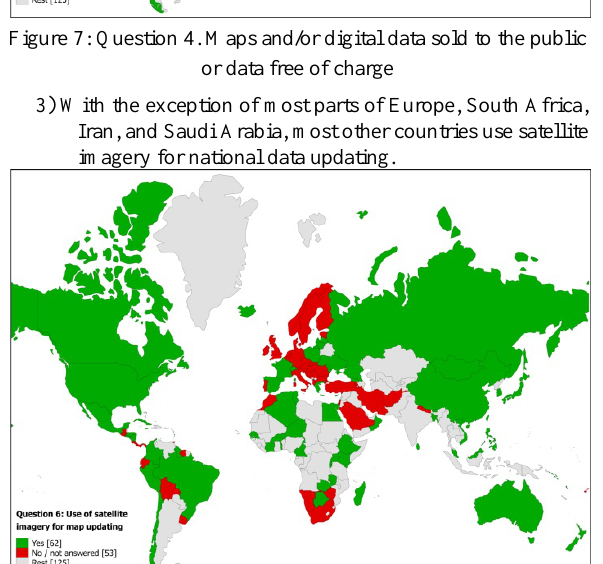
Figure 4: Map coverage at scale 1:100 000